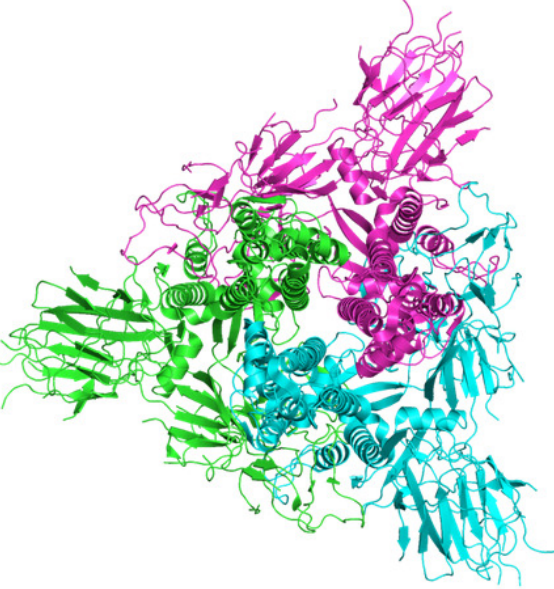
Figure 1. A picture of the secondary structure of D614G variant (minus RBD) of the SARS-CoV-2 spike protein found in the protein data bank in Europe